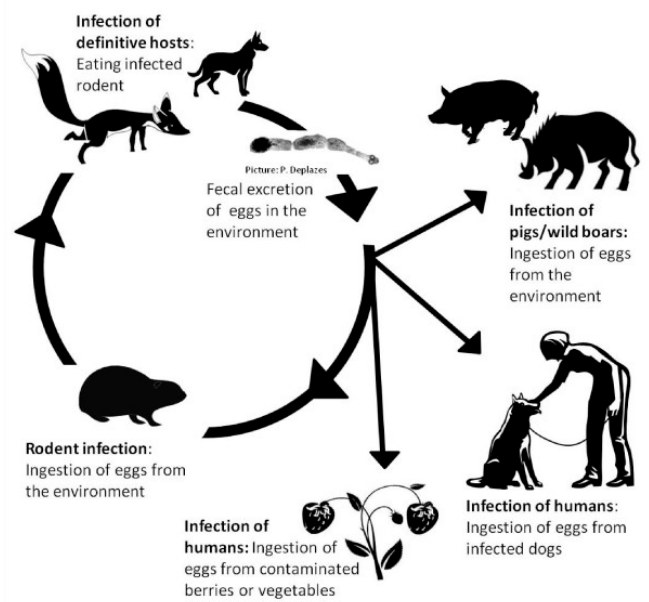
Figure 2. Life cycle of E. multilocularis [7]. Copyright notice: The link of original article: (https: // actavetscand.biomedcentral.com / articles / 10.1186 / 1751-0147-53-9), the link of the Creative Commons Attribution License (http: // creativecommons.org / licenses / by / 2.0), if any changes were made in the original picture: (cid:3)